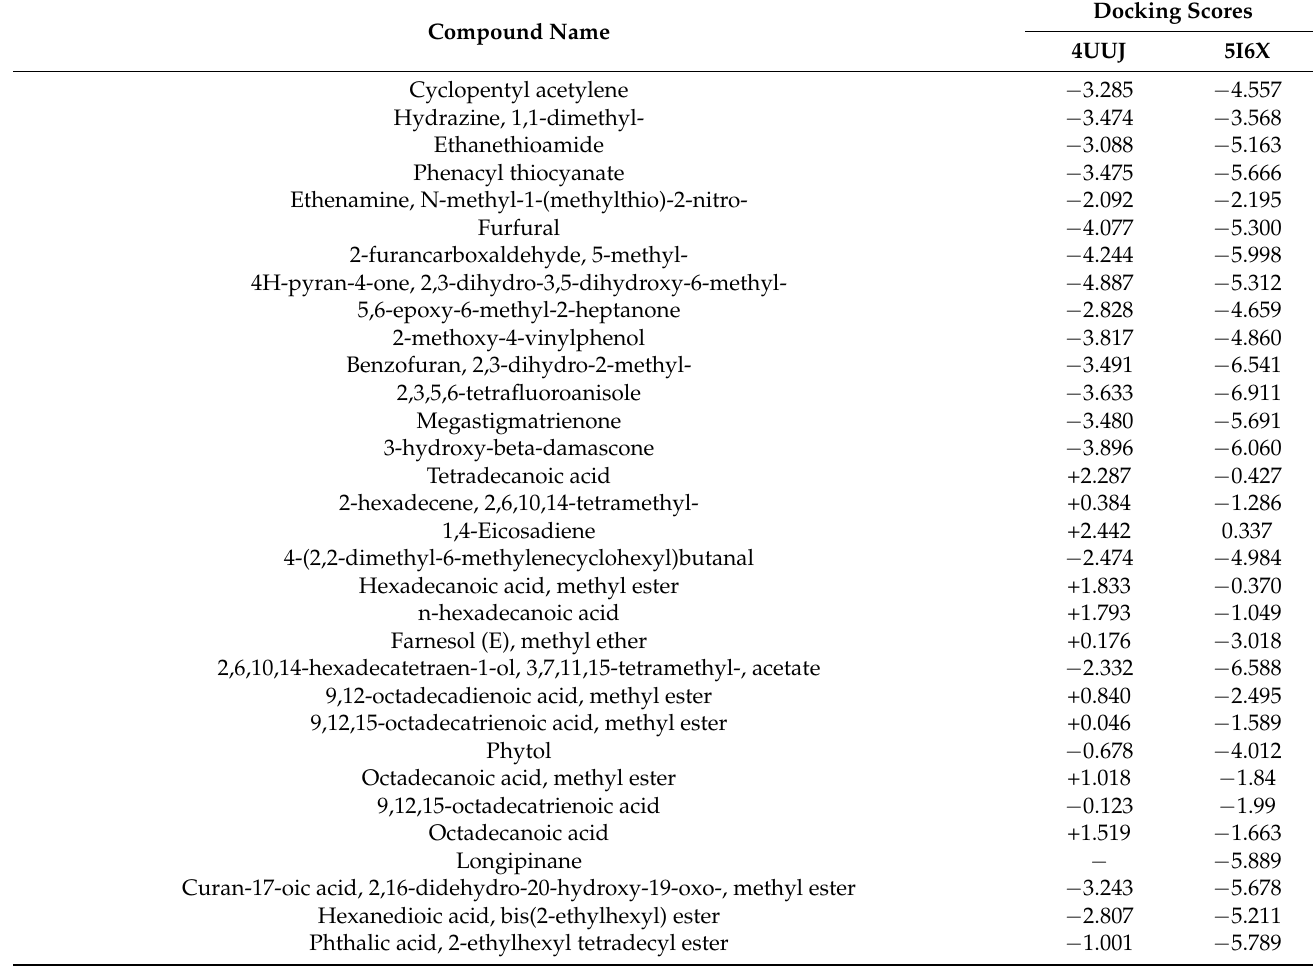
Table 2. Docking scores for the identified compounds from the methanol extract of Cnesmone javanica. Compound